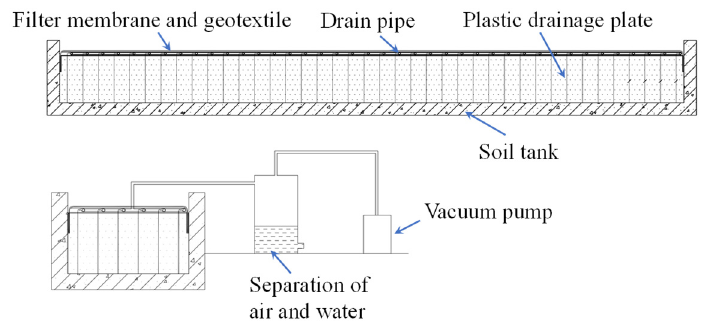
Figure 13. Vacuum preloading system.